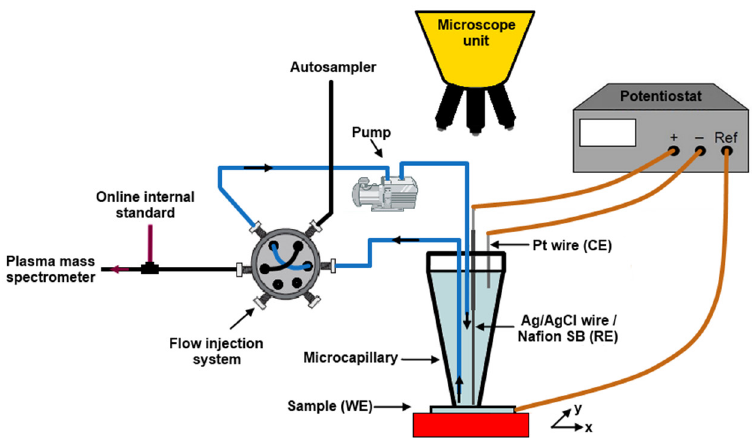
Figure 13. Schematic of the microcapillary flow ICP MS setup, re-drawn from reference